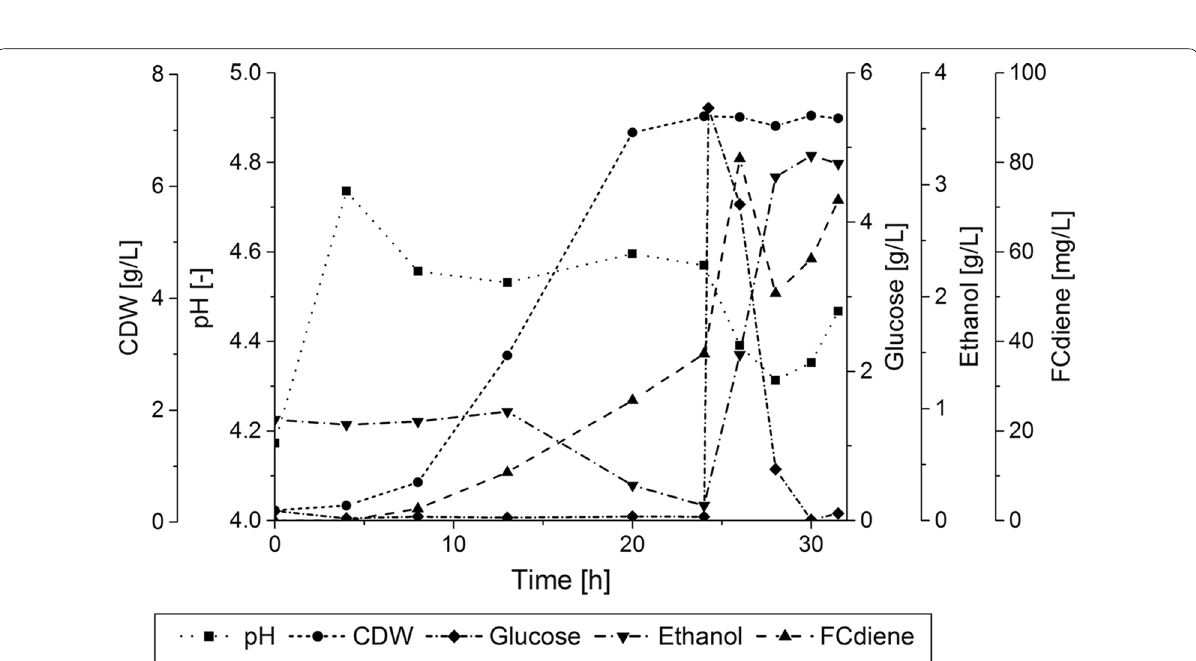
Fig. 7 Bi-modal cultivation of S. cerevisiae growing in SD medium with glucose as sole carbon source. Cell dry weight concentrations, pH, glucose; ethanol and FCdiene concentrations of fed-batch fermentation (0–24 h) with combined glucose pulse in the KLF2000 fermenter (working volume 1.8 L) are shown. In the fed-batch phase, the pH was regulated using ammonia solution (6.65 M), in the batch phase the pH was